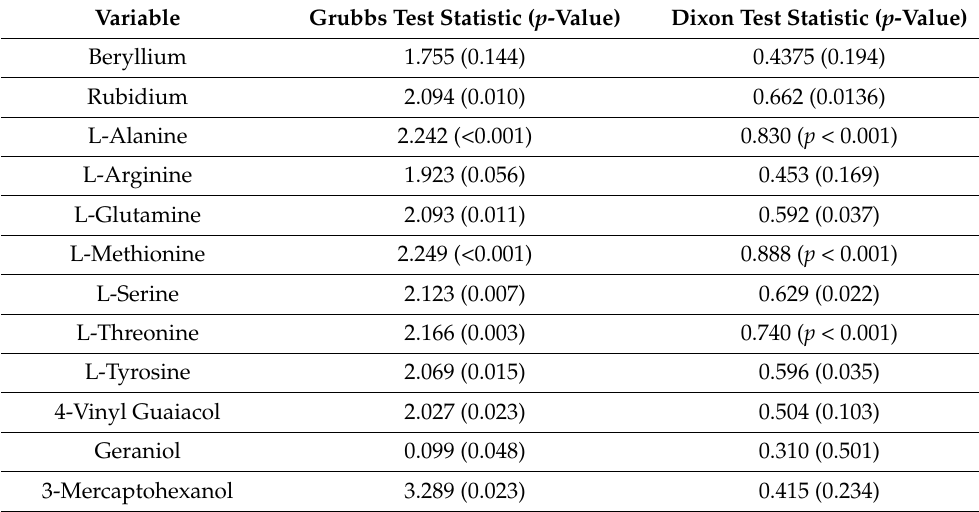
Table 9. Grubbs and Dixon tests.